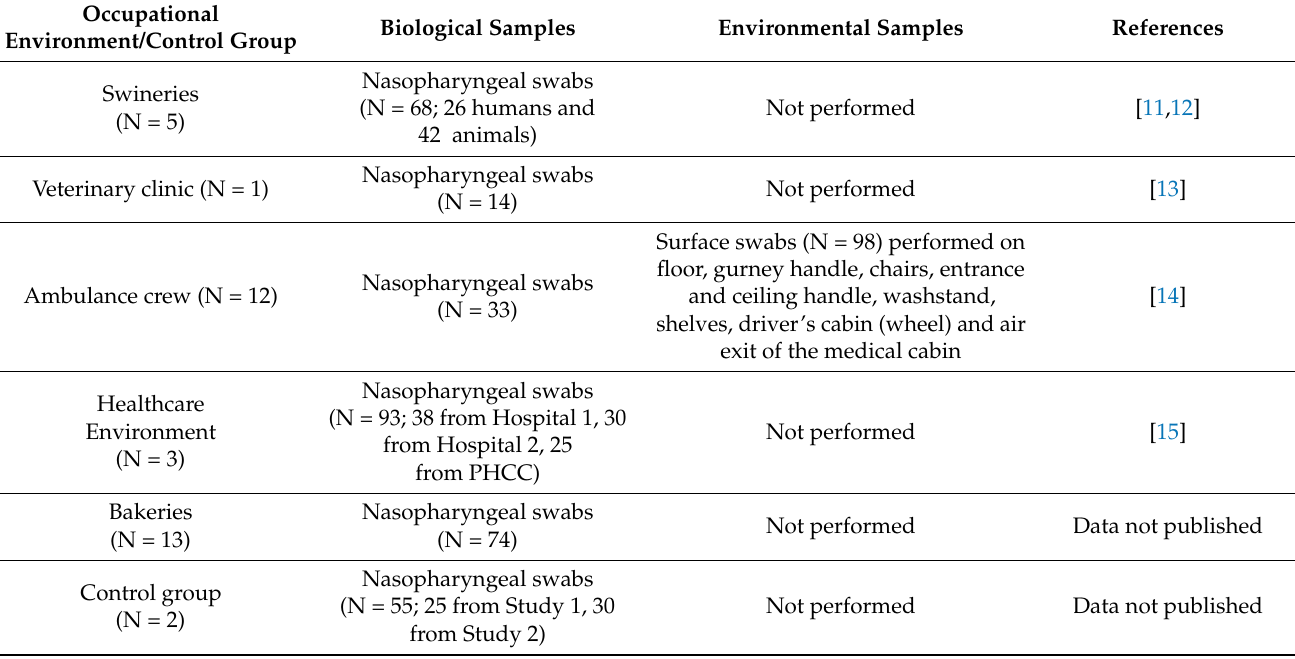
Table 1. Environmental and biological samples collected in each workplace